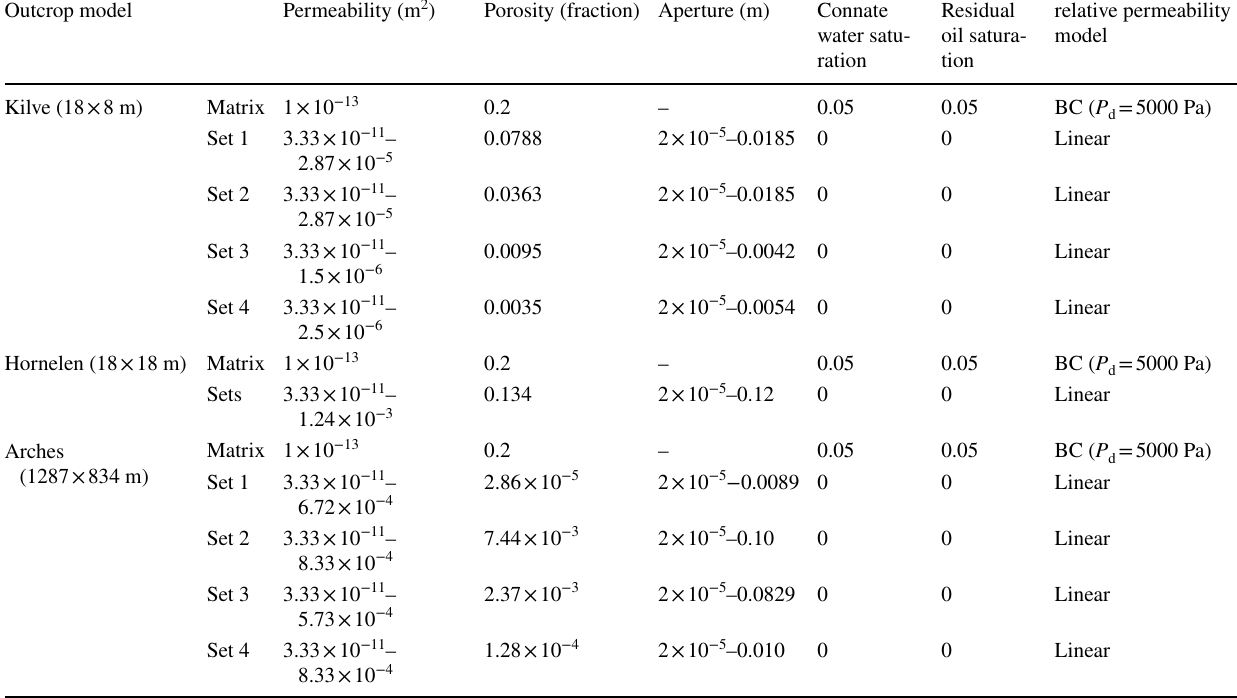
Table 2 List of parameters that are used for the simulation of the models Outcrop model